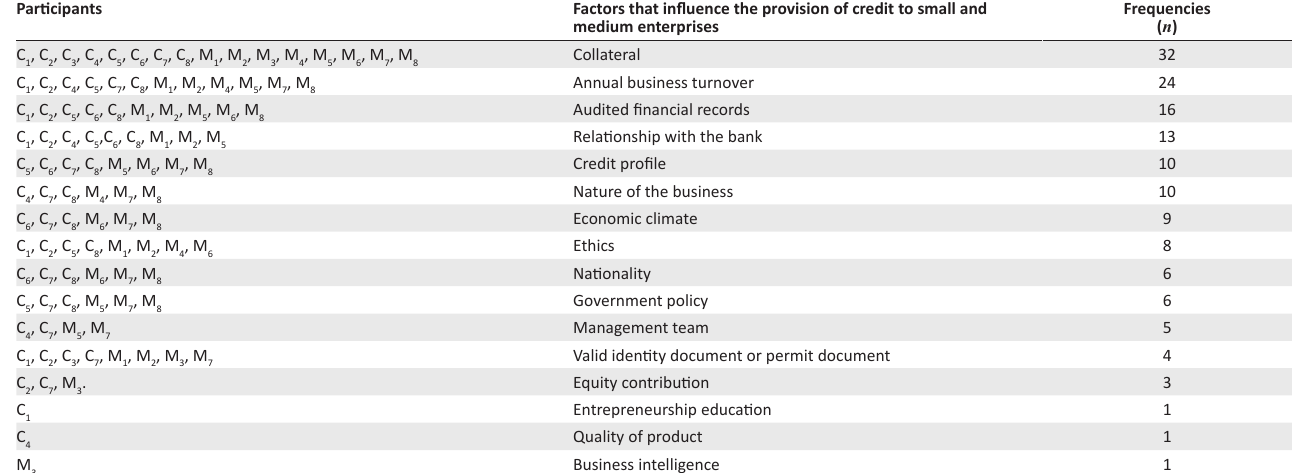
TABLE 2: Perspectives of participants regarding the factors that impact the willingness of the formal financial sector to provide credit to small and medium enterprises. Participants Factors that influence the provision of credit to small and